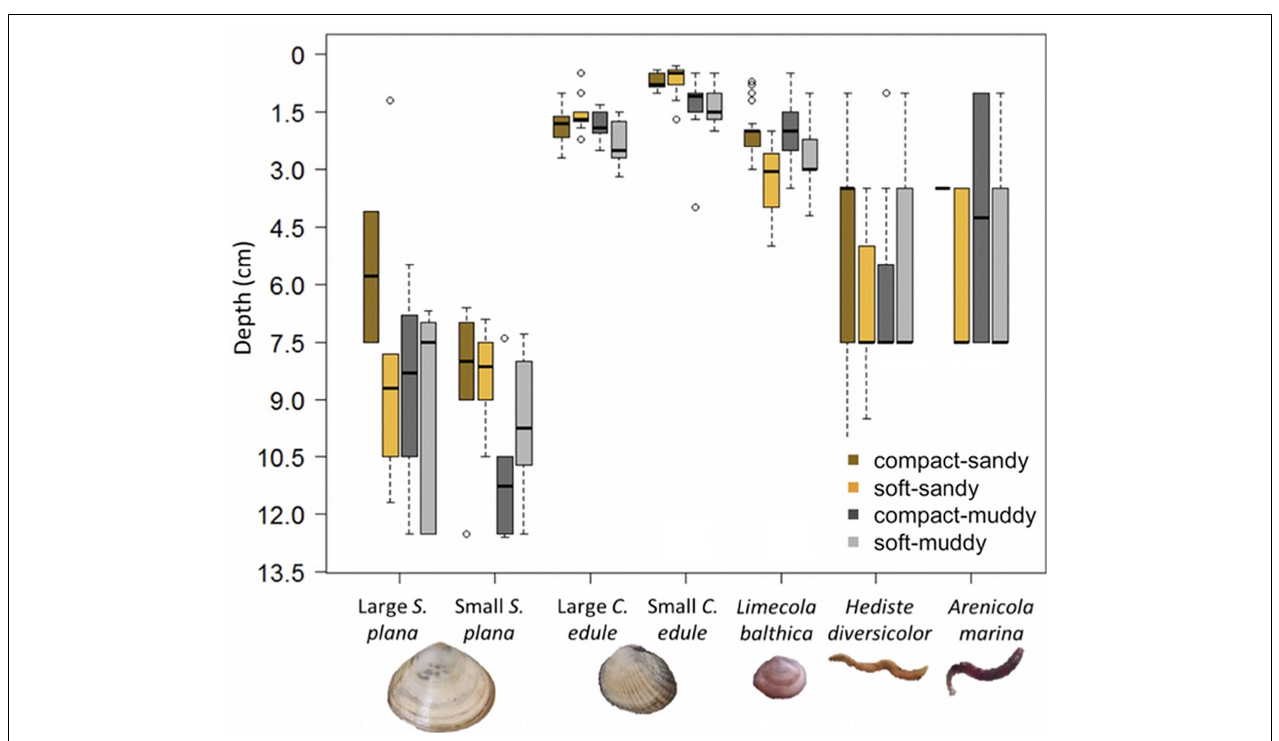
FIGURE 6 | Boxplots of burrowing depth by species and sediment treatment, where the box (25–75% of the data) contains a black line (median) and has whiskers extending to the minimum and maximum data values, with outliers as open circles. Bivalve burrowing depth was measured precisely (lowest point animal). Polychaete burrowing depth was measured by strata (0–2 cm, 2–5 cm, and 5–12 cm) and extrapolated to the mean value of each stratum. For some H. diversicolor , a burrow point was visible and was used instead of the strata. Note that the bottom of the pots was at 12.5 cm which is close to many of the S. plana positions. The sediment treatments only had a significant effect on the burrowing depth of L. balthica and the small C. edule